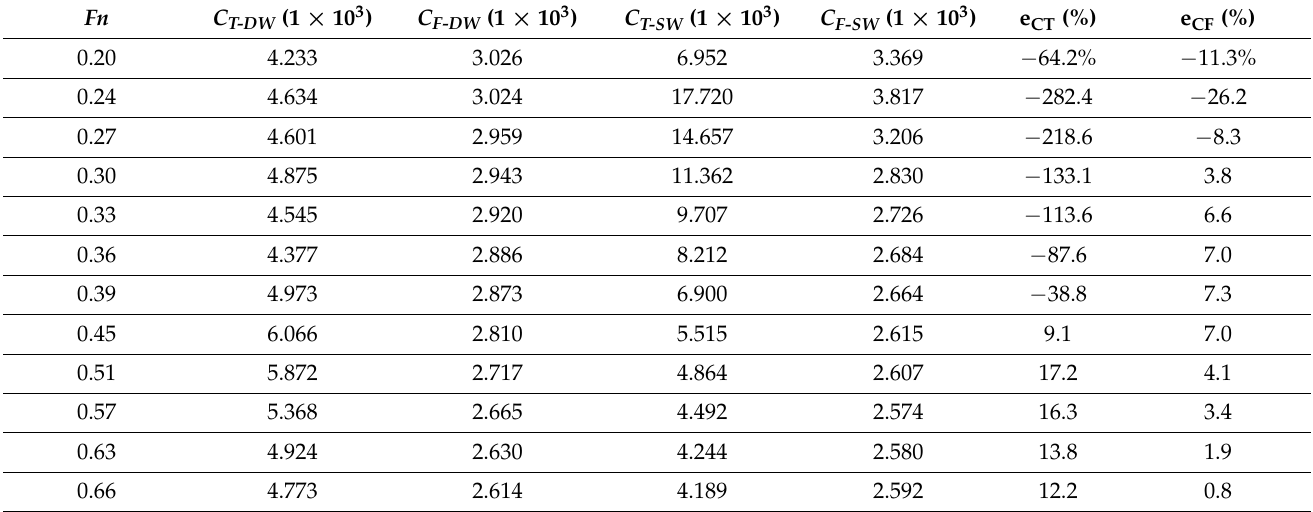
Table 7. Resistance results of the catamaran in deep and shallow water at LC2.